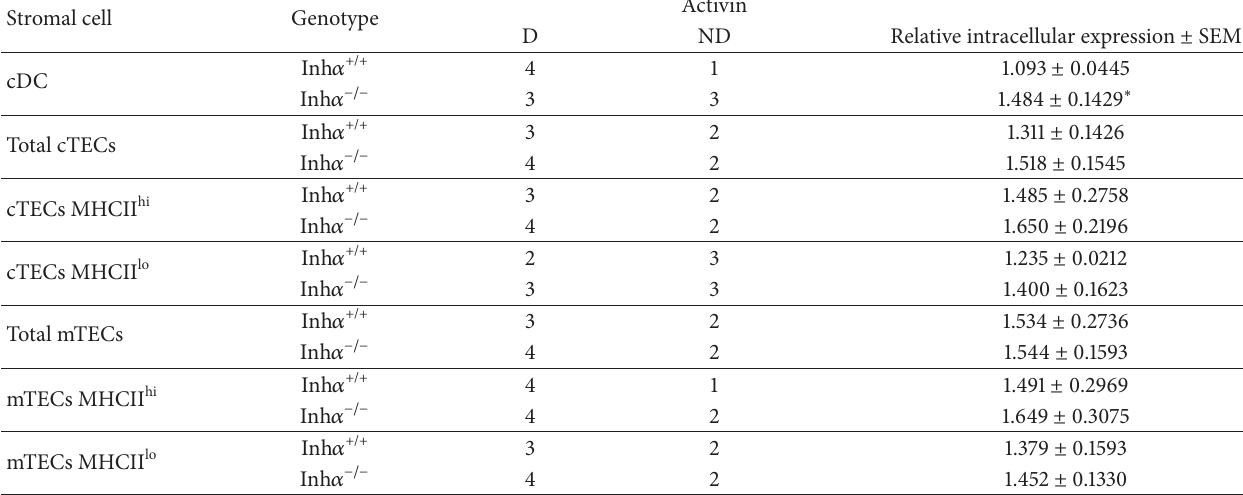
Intracellular levels of Activin were measured by flow cytometry, using surface markers to differentiate different stromal cell subpopulations: cDCs (CD45 + CD11c + MHCII + ); cTECs (CD45 − MHCII + Ly51 + ); mTECs (CD45 − MHCII + Ly51 − ). MHCII high and low subpopulations were also analyzed to define mature versusimmaturesubpopulations,respectively.RelativeintracellularexpressionofActivinAwascalculatednormalizingtheMFIfromeachsampletotheMFIof thesecondaryantibodycontrolfrommiceincolumnD.D:numberofmicewithdetectableActivinlevels;ND:notdetectable.Statisticalsignificance: ∗ 𝑃 ≤ 0.05